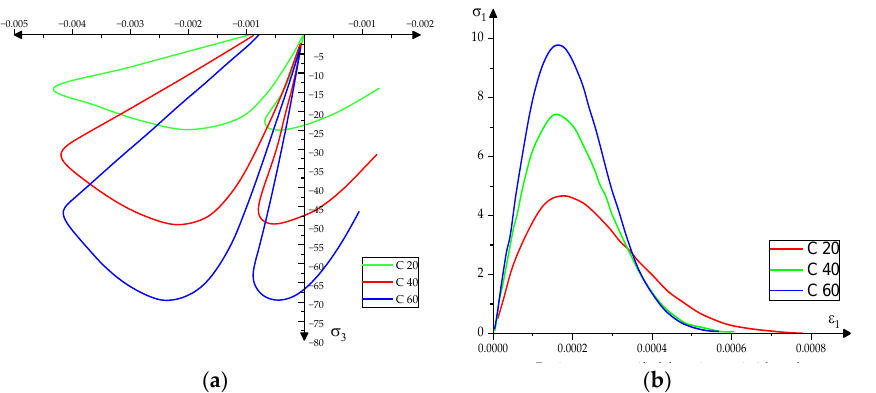
Figure 5. The constitutive model of the concrete required for impulse-type actions depending on the grade of concrete C20, C40, C60 ( a ) tension curves-specific deformation at uniaxial compression ( b ) tension curves-specific deformation at a uniaxial stretch.